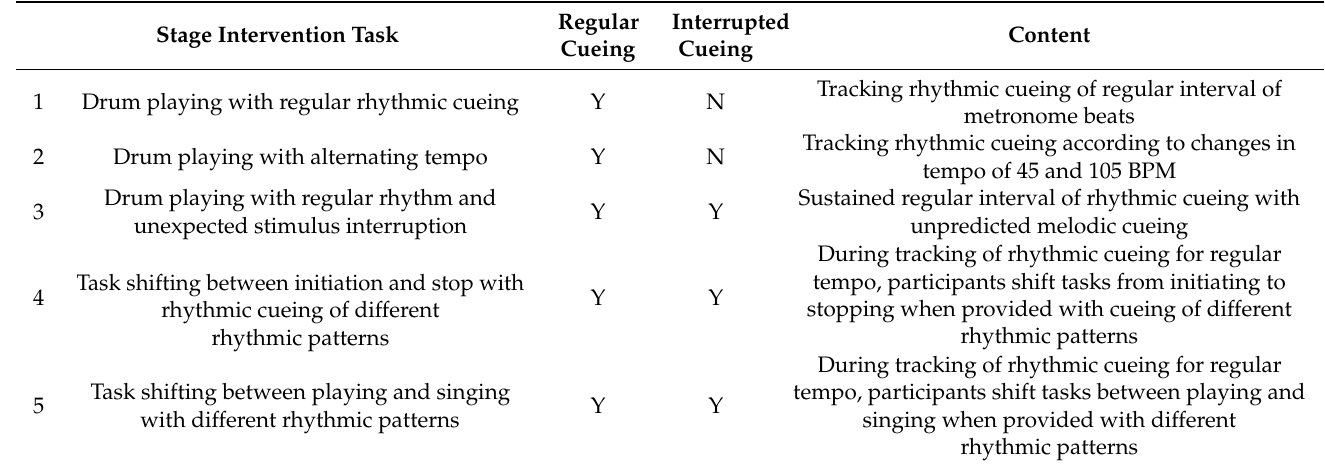
Table 2. Intervention of drum playing with rhythmic